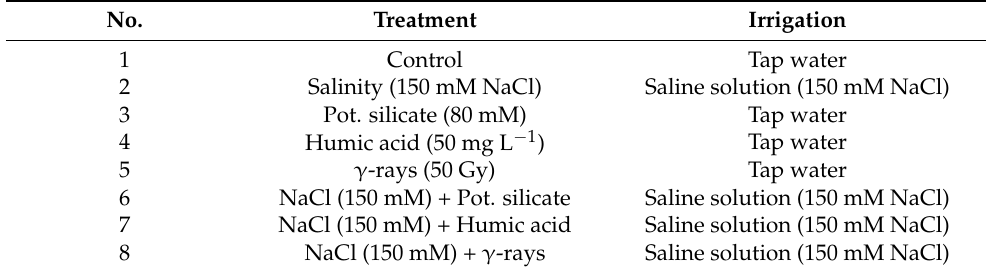
Table 1. Experimental design and regime of primed seeds of coriander by tap water, solutions of 80 mM pot. silicate or 50 mg L − 1 HA or irradiation by 50 Gy γ -rays then primed in water at room temperature (20 2 ◦ C) for 16 ±